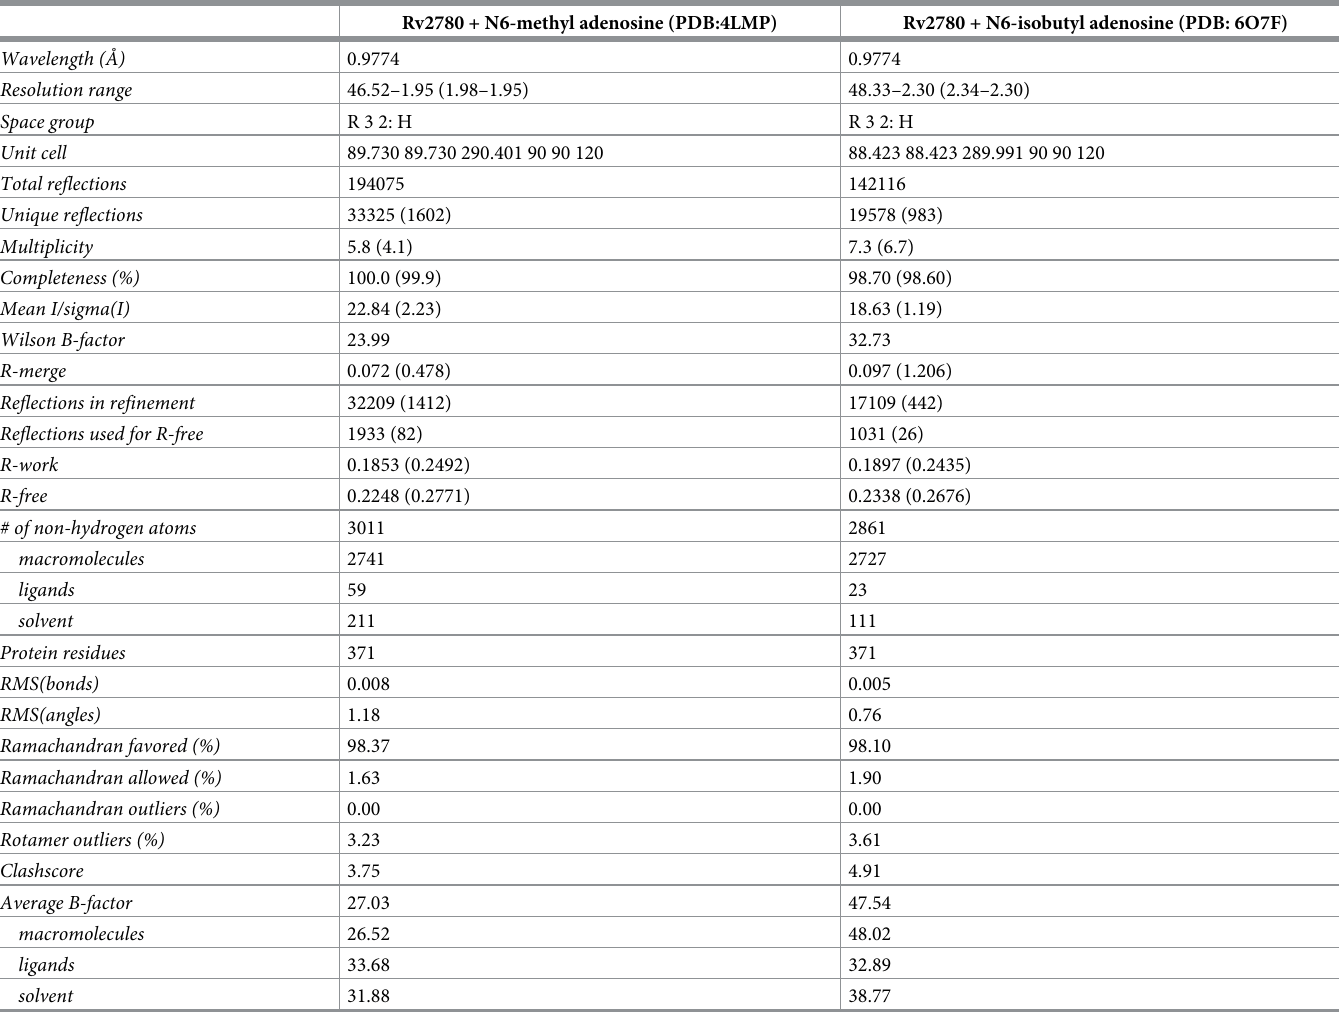
Table 1. Data collection and refinement